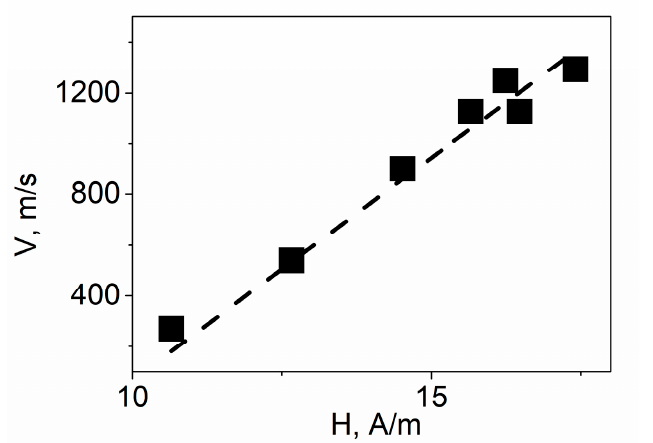
Figure 6. Dependence of the velocity of the DW on the external magnetic field in the area of the microwire corresponding the room temperature.